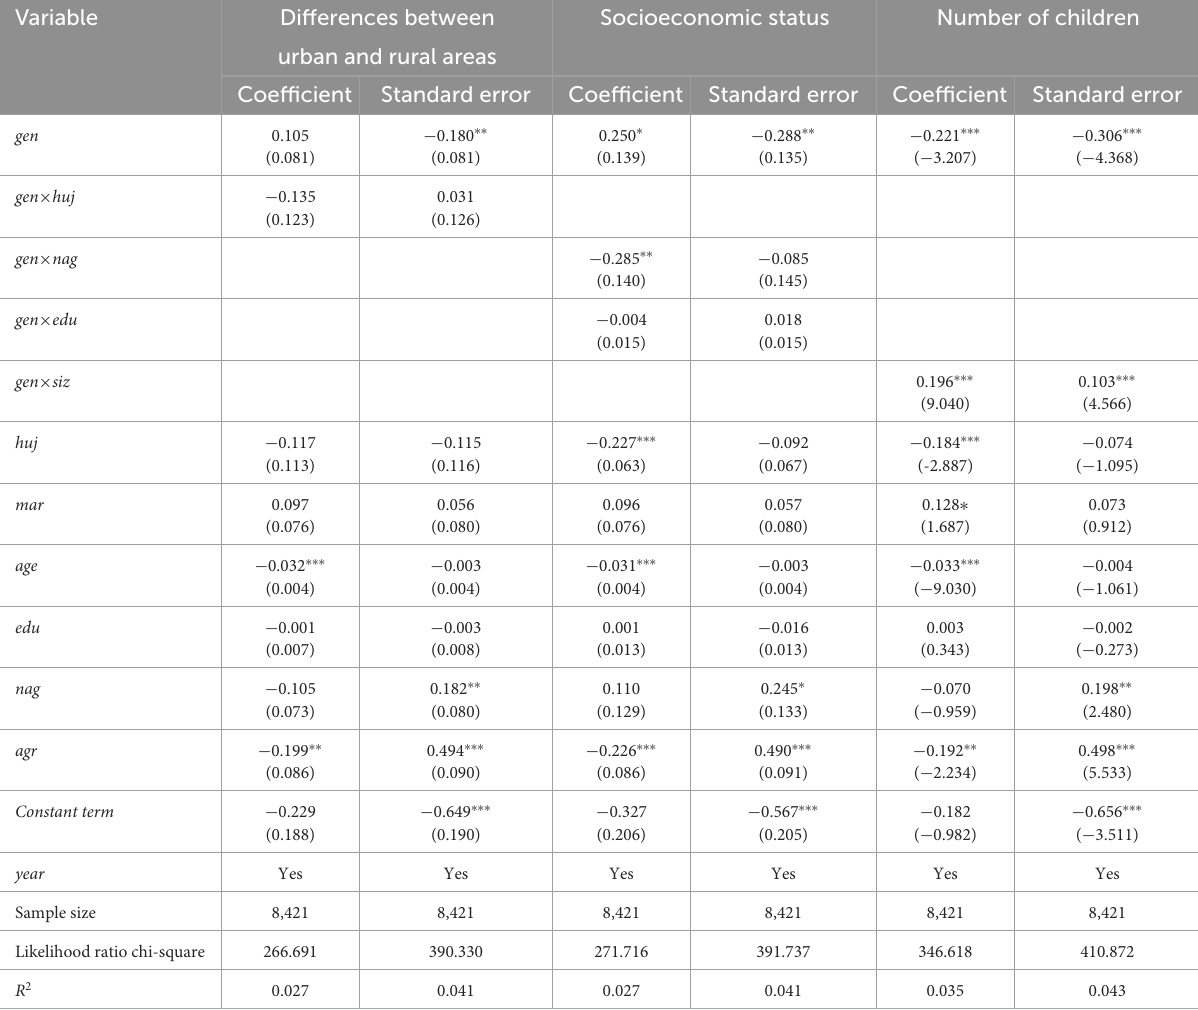
TABLE 9 Robustness estimation results for the effect of children’s gender role on the ways in which they support their parents.